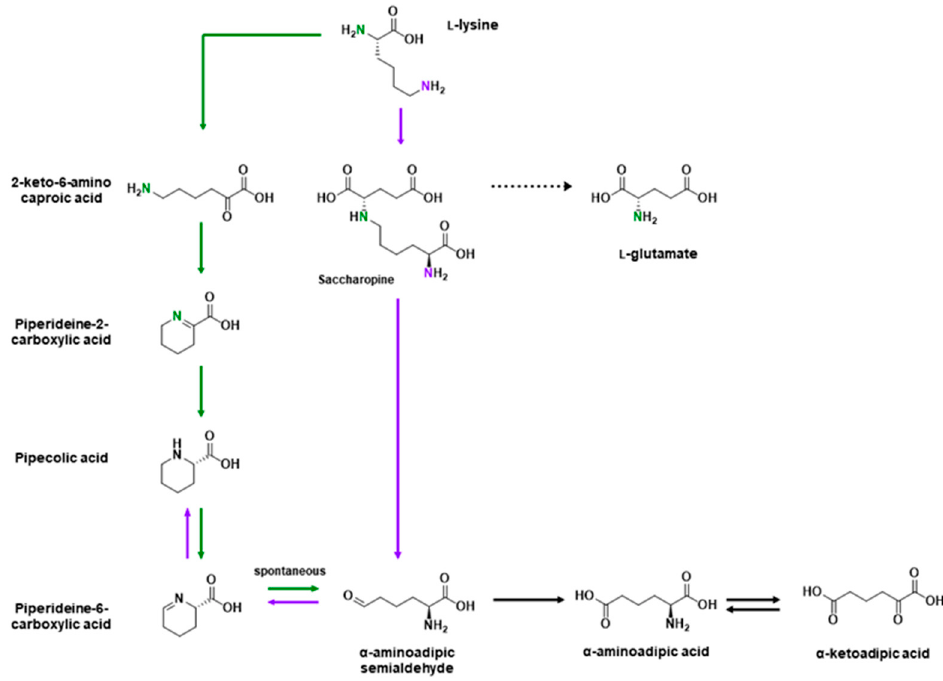
Figure 2. Metabolic pathways of l -lysine. l -Lysine is metabolized either through the saccharopine pathway (purple arrows) or the pipecolic acid pathway (green arrows). The two nitrogen atoms from lysine are colored in purple and green to enable atom tracing, but this distinction is lost in metabolites accessible to both pathways (i.e., pipecolic acid to α -ketoadipic acid). Adapted from Crowther et al. [142] .